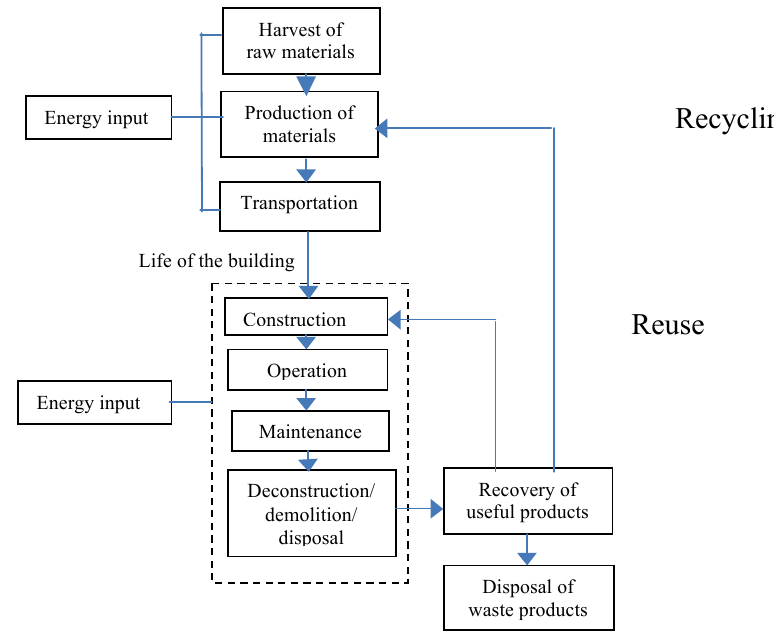
Figure 3. Stages of energy input during the life of a